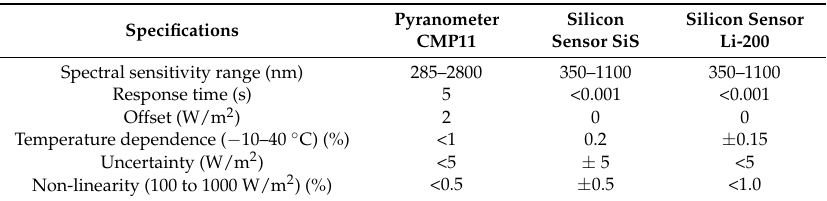
Table 2. Comparison of the specifications of the sensors